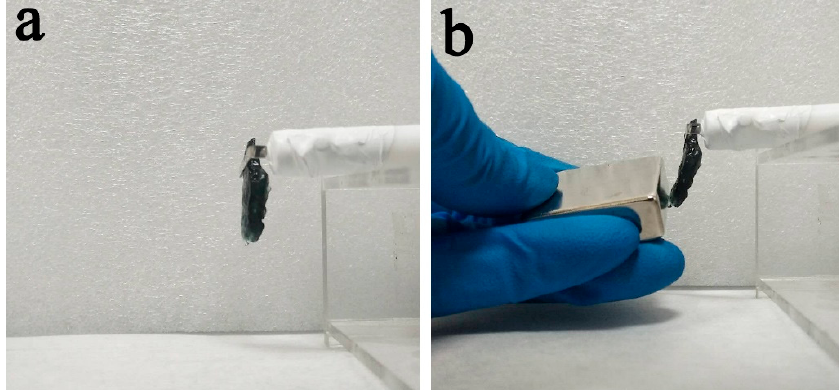
Figure 9. Chitosan film ( a ) hanging on electrode, ( b ) being attracted by a magnet.